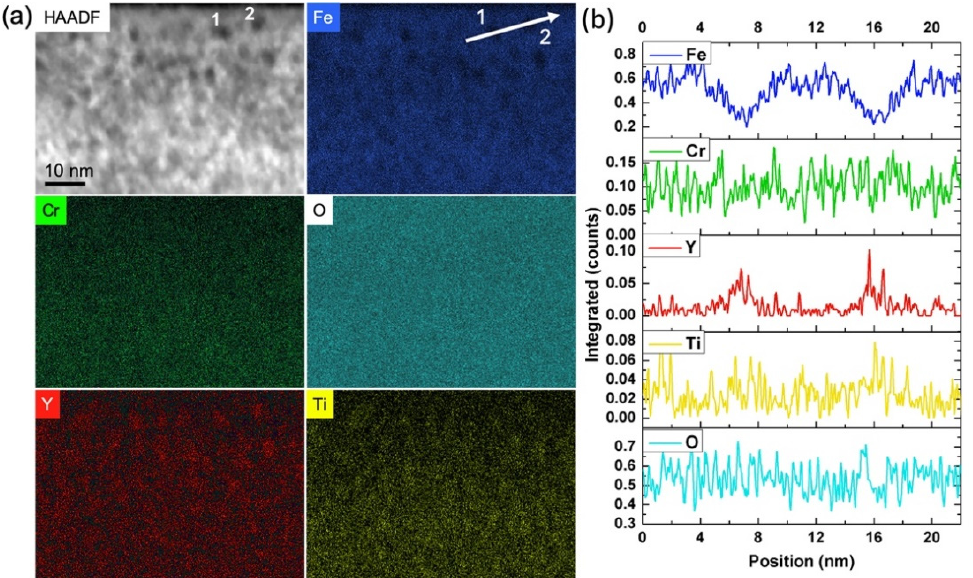
Figure 6. ( a ) STEM-HAADF and STEM-EDX imaging of FeCr implanted with Ti, Y, and O ions in the sequential order Y → Ti → O and subsequently annealed at 800 ◦ C for 2 h. ( b ) One-dimensional line scans through two precipitates labelled 1 and 2 and highlighted in ( a ) on the Fe elemental map. The oxide precipitates are observed with a dark contrast on a lighter background in the STEM-HAADF image.